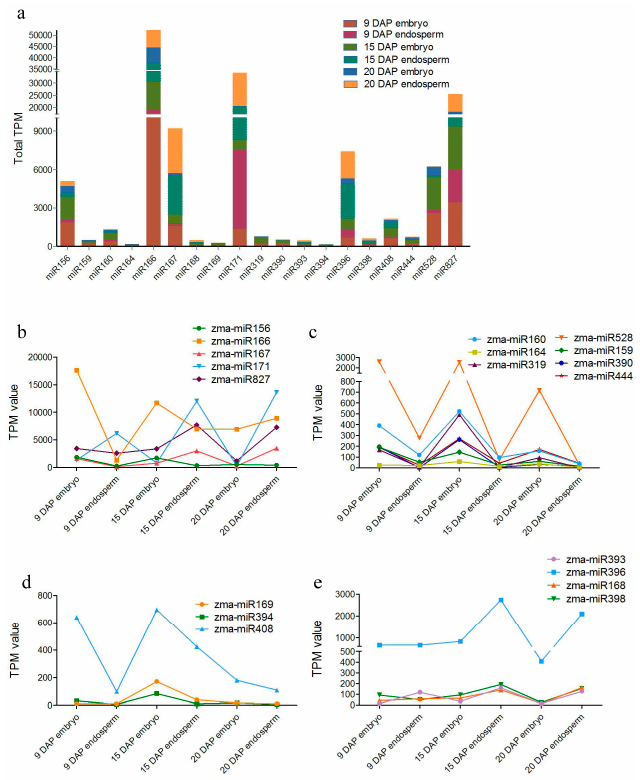
Figure 3. Summary of highly expressed and kernel-specific miRNAs in the maize embryo and endosperm. The total number of sequences from six libraries is presented in terms of transcript per million (TPM). ( a ) Distributions of highly expressed miRNA. ( b – e ) The expressional patterns of highly expressed miRNAs.